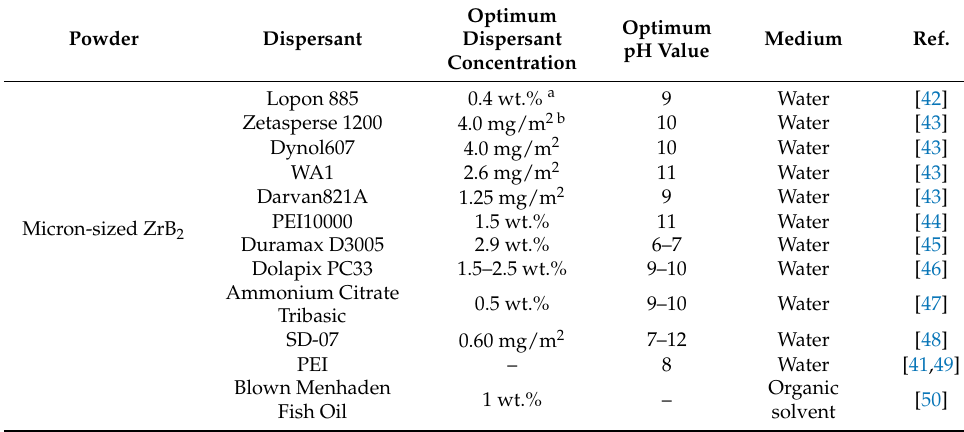
Table 1. Summary of the dispersion of the ZrB 2